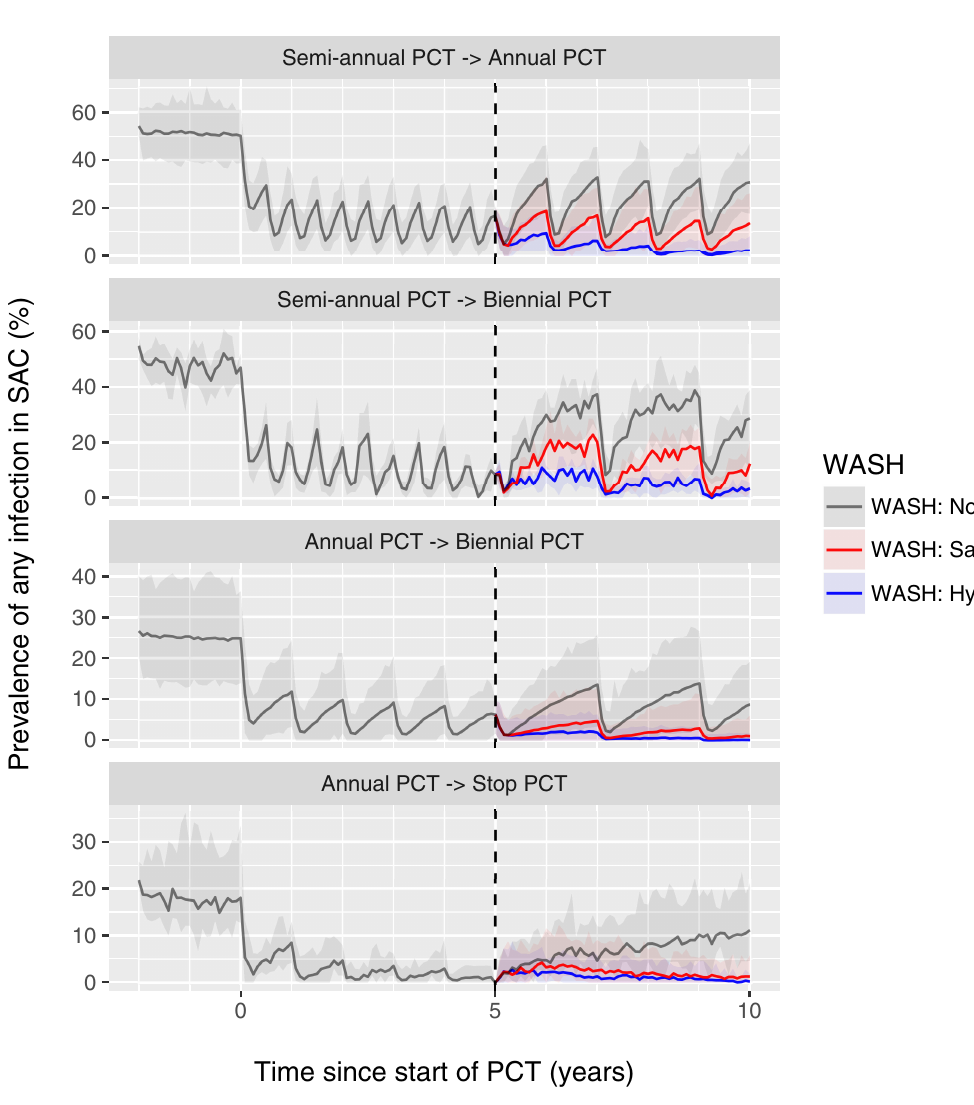
Fig 3. Model-predicted additional impact of WASH on hookworm prevalence in settings where school-based is scaled down or stopped. Lines represent the average of repeated simulations with random pre-control transmission conditions that followed a specific path through a decision tree for scaling down or stopping PCT as follows. Shaded areas represent the 2.5 th and 97.5 th percentiles of the stochastic variation in repeated simulations. For every single simulation, PCT was initiated at semi-annual or annual frequency (90% coverage of SAC) if pre-control infection prevalence in SAC was > 50% or between 20% and 50%, respectively; at midline (after 5 years of PCT, dashed vertical line) the PCT frequency was scaled down from semi-annual to annual if prevalence of infection in SAC was between 10% and 20%, and was scaled down to biennial (from either annual or semi-annual) if the prevalence of infection was between 1% and 10%. PCT was stopped if the midline prevalence of infection in SAC was < 1%. WASH interventions were assumed start at midline and to be taken up by 70% of the population and to result in a 95% reduction in participating individuals’ contribution (sanitation) or exposure (hygiene) to the environmental reservoir of infection. Pre-control endemicity differs between the panels because the different paths through the decision tree are more likely in some transmission conditions than others (e.g. the decision to stop PCT only comes up in situations with relatively favourable (low) pre-control endemicity). Depicted average trends are the net effect of potential interruption of transmission in some simulations and bounce-back in others. Similar figures are available for other STH species and settings where PCT is implemented community-wide (age 2 and above) at 75% coverage (S4 Fig).